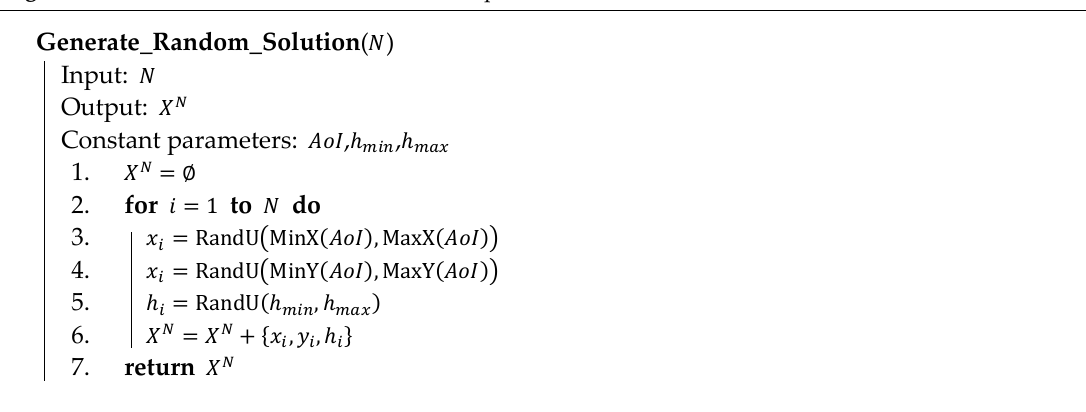
Algorithm 4 Generation of a random solution in pseudocode